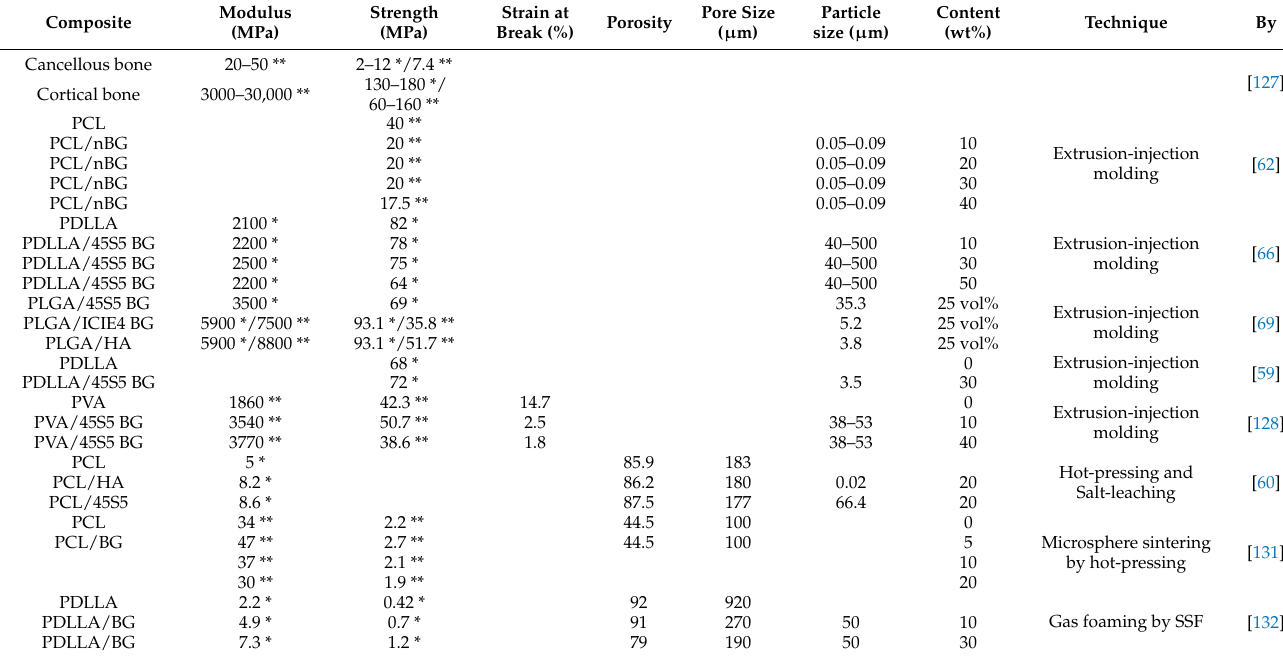
Table 2. Principal properties of extrusion-injection molding investigations. With * the compression, ** tensile (not filled cells mean no